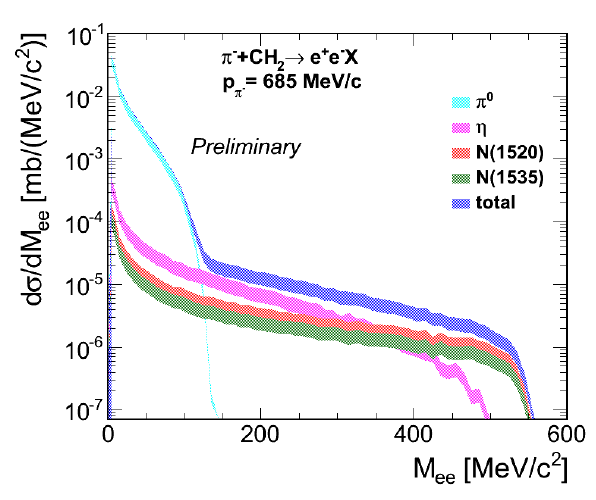
Figure 6. Di ff erential cross sections as a function of the e + e − invariant mass for the di ff erent contributions used as inputs for the simulations of the π − p → n e + e − X reaction at an incident pion momentum of 0.685 GeV /